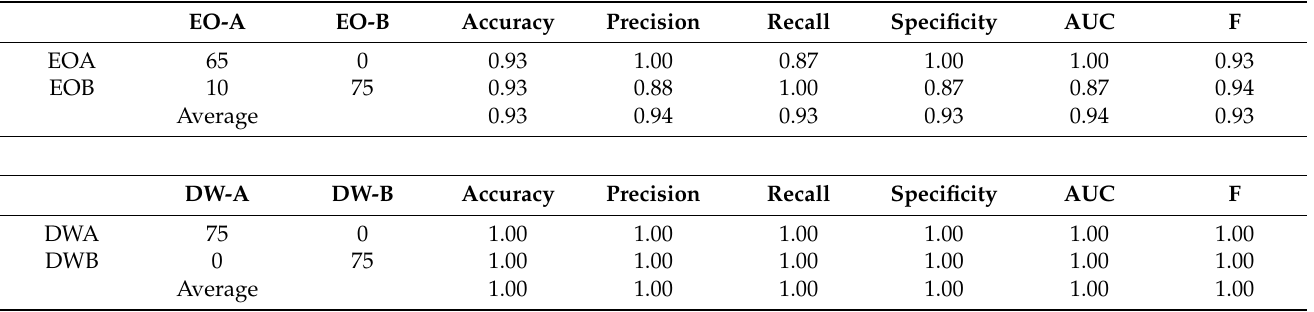
Figure 7. LDA results for classification of two groups ( a ) mint EO (blue squares), and ( b ) mint DWE (red circles). Table 4. Confusion matrix and performance parameters of LDA methods for classification of two